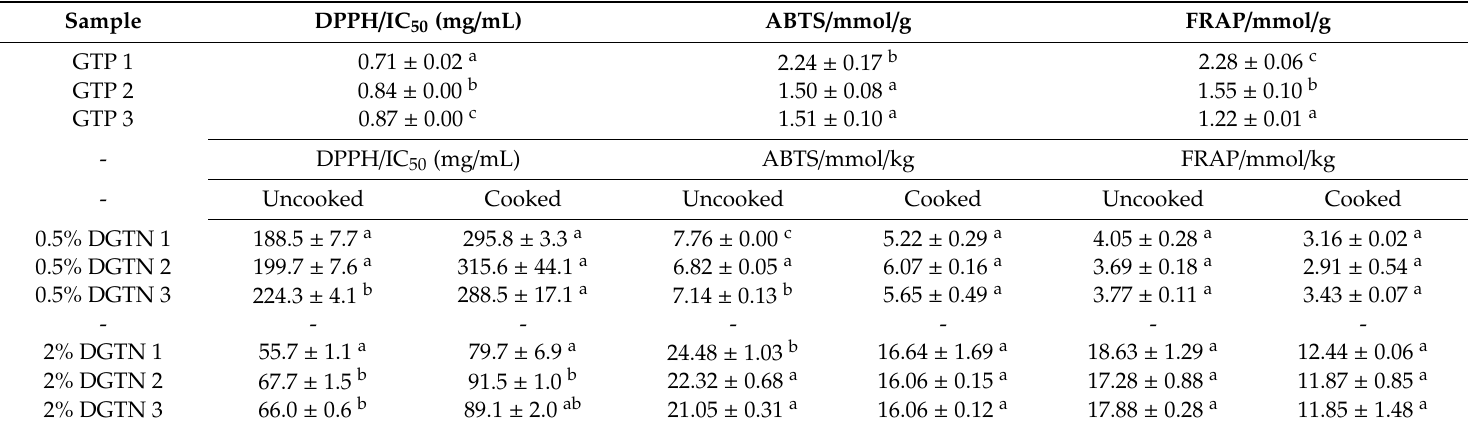
Table 3. Changes in antioxidant activities of GTPs and DGTNs before and after water